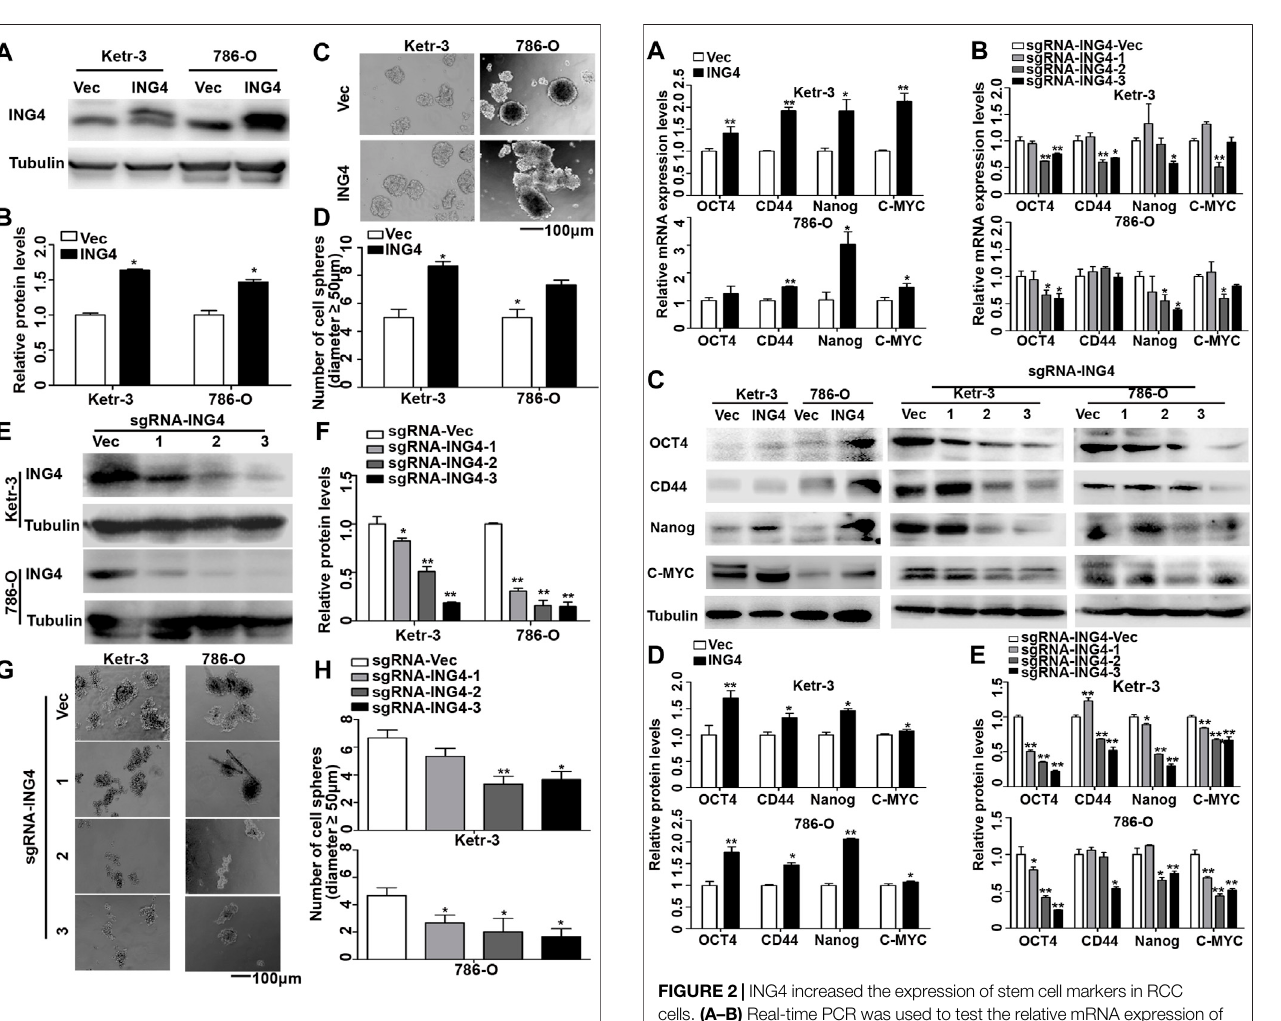
FIGURE 1 | ING4 promoted the formation of RCC cell sphere. (A – B) Lentivirus-mediatedING4anditsvector(Vec)wasstablyoverexpressedinthe Ketr-3 and 786-O cells and relative protein expression of ING4 was normalized to that of the respective α -tubulin. (C – D) Photographs and numberofcellspheresinING4overexpression(ING4)andcontrol(Vec)Ketr-3 and 786-O cells (n = 3). (E – F) Three lentivirus-mediated ING4-targeted sgRNAs (sgRNA-ING4) and vector (sgRNA-Vec) were used to stably knockdowntheING4expressioninKetr-3and786-Ocellsandrelativeprotein expression of ING4 was normalized to that of the respective α -tubulin. (G – H) Photographs and number of cell spheres in ING4 knockdown and control Ketr-3 and 786-O cells (n =3). Imagemagni fi cation, ×100; scale bar, 100 μ m; data are presented as mean ± standard deviation. *p < 0.05, **p < 0.001.